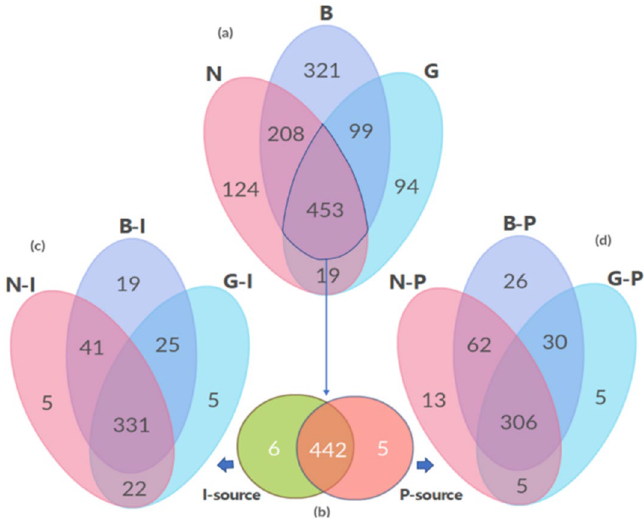
Figure 3. Venn diagram of shared and uniquely identified OTUs among the three sampling locations (a), where the common OTUs were counted by source (I or P; b). For each source, OTUs were separated by sample locations, respectively (c &